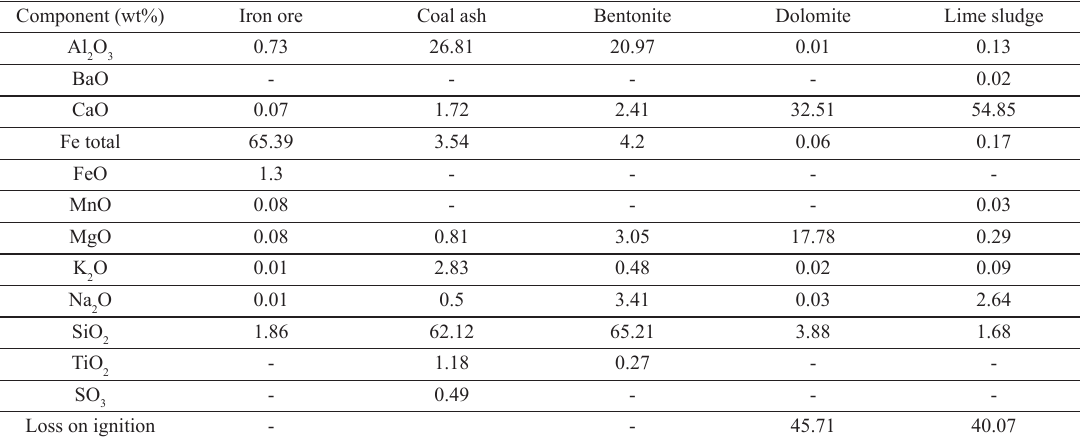
Table 1. Chemical compositions of the iron ore, dolomite, and lime sludge used as inputs for producing iron-ore pellets. Component